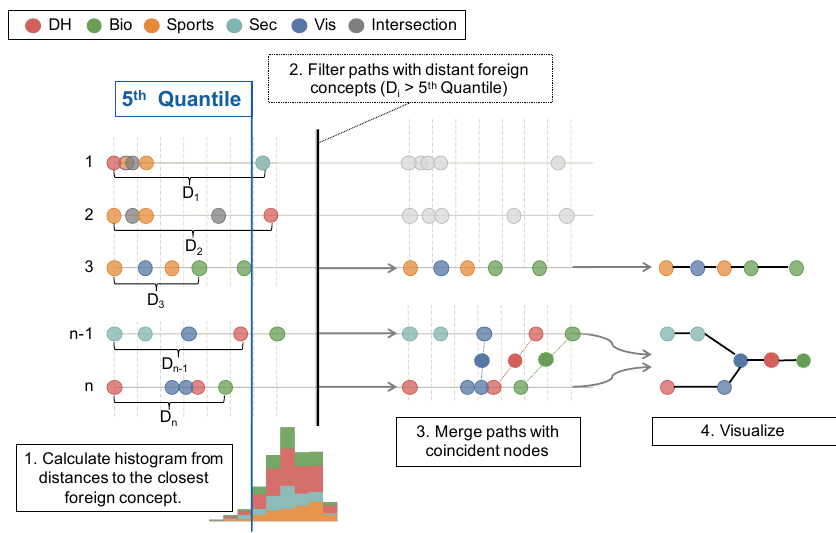
Figure 8. Chart depicting the process to compose inter-domain paths. The method relies on calculating a histogram of distances to find a cut-off value used to remove long paths from the final visualization. To filter out paths and terms presenting long distances to other terms, we purposely selected a highly restrictive cut-off value (5th percentile, x = 0.3408) to focus the visualization on